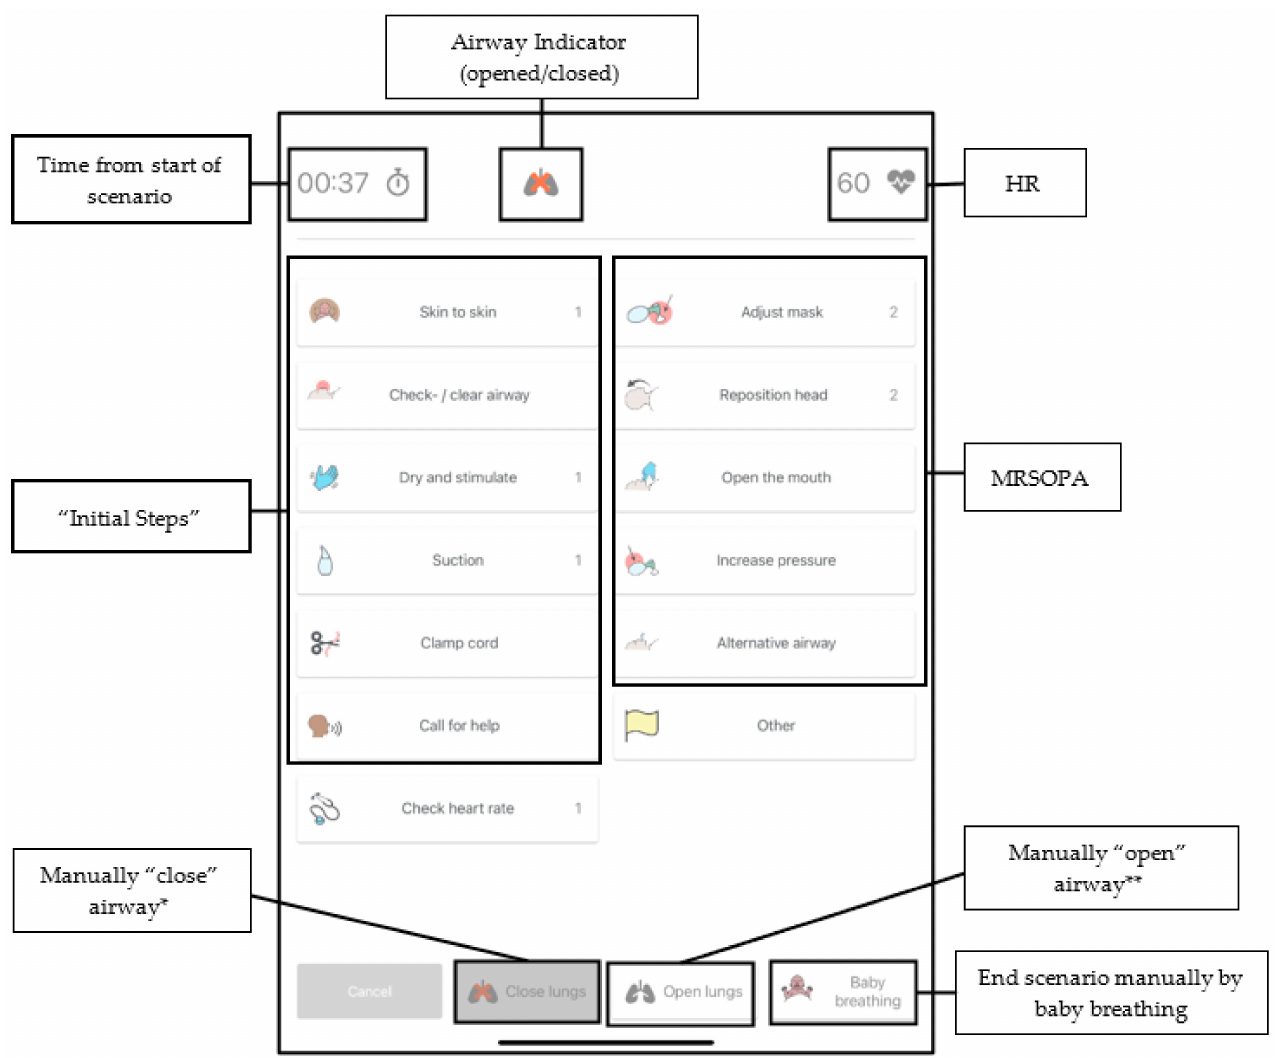
Figure 2. Screenshot of the tablet application. Each button denotes a resuscitation step that may be performed. The facilitator taps each button as the learner performs a particular step in real time, creating a detailed timeline of the performance. (Left column): “initial steps” (airway clearance, dry/stimulate, suction, call for help, etc). (Right column): ventilation corrective steps